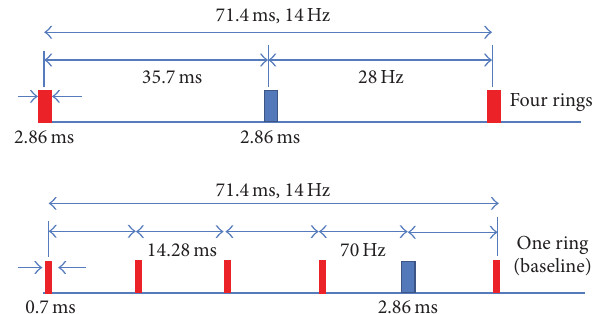
Figure 12: Pulse distribution for the case with four stacked accu- mulators and for the one-ring options: the upper part of the figure shows the 28 Hz pulsing of the linac with one proton (blue) and one H − (red) pulse interleaved and the lower part shows the case of four 0.72 ms long pulses of H − for neutrinos which are followed by one 2.86 ms proton pulse for the neutrino spallation target. The upper case needs a switching system and gaps in the H − pulse to distribute the particles in the four stacked rings.